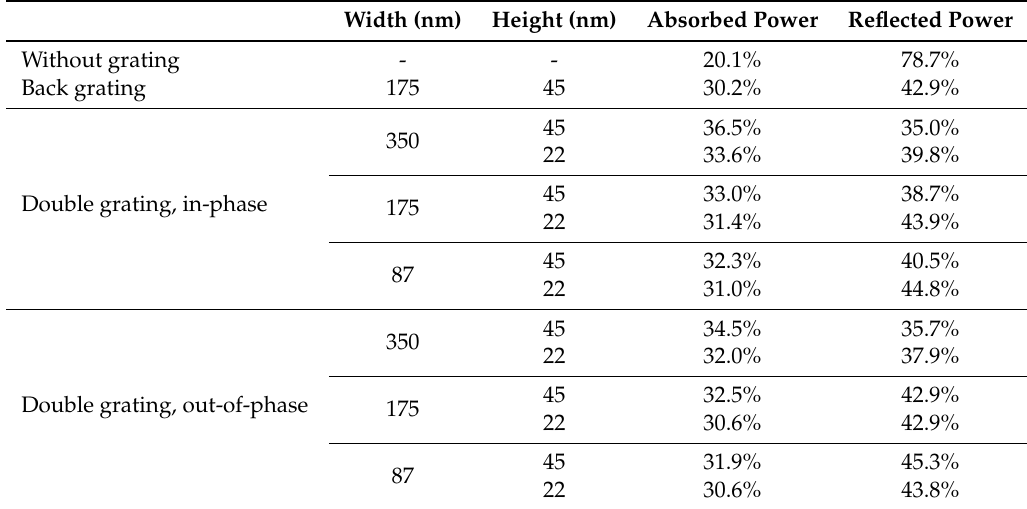
Table 1. The percentage of spectrally integrated absorbed power as well as the reflected power relative to the total illuminated power for the periodic double grating designs together with structures without a grating and with only a periodic back